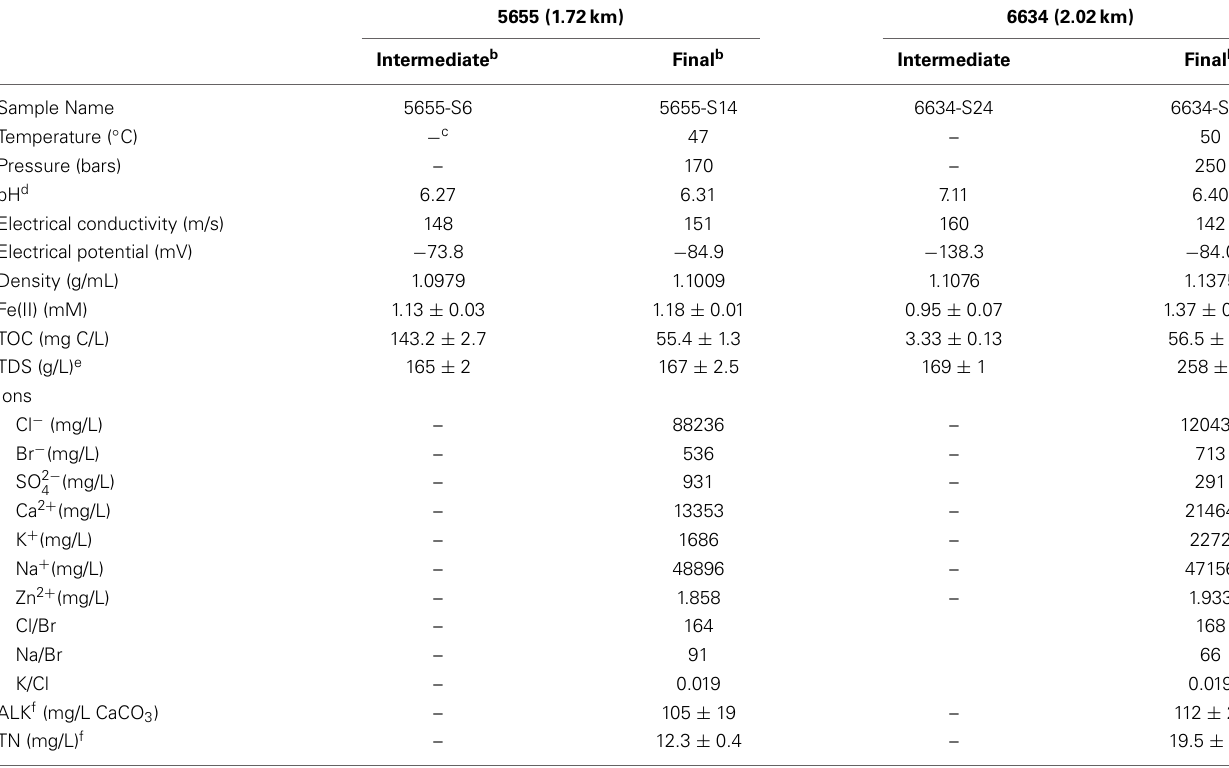
Table 1 | Geochemistry of formation water a